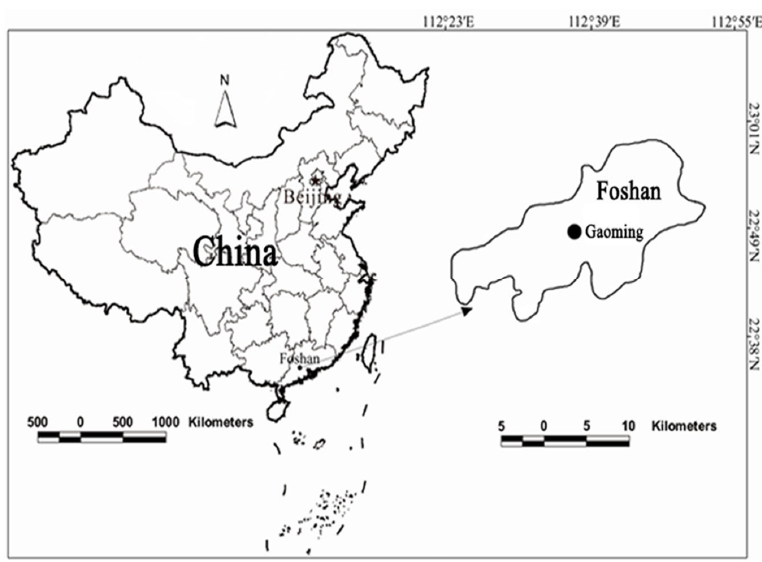
Figure 1. Location of study sites (black circles) in Gaoming of Foshan City, Guangdong, China. Table 1. The effect of five meteorological factors in the period of investigating.